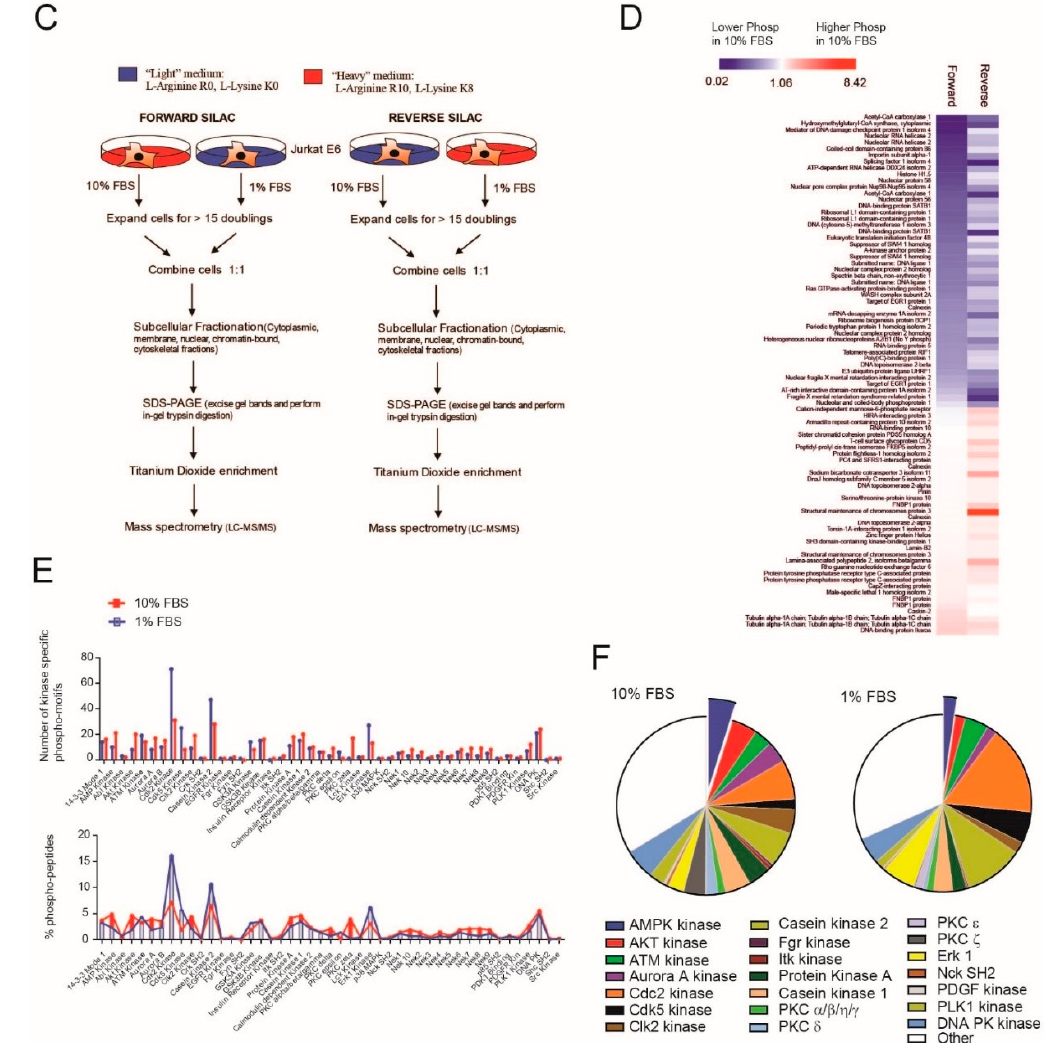
Figure 1. Serum deprivation augments sensitivity to the cytotoxic effects of Hedgehog pathway inhibitors such as GANT-61 through the modulation of numerous signaling pathways. ( A ) Cell viability assays in T-ALL cell lines (Jurkat (24 h), KOPTK1 (48 h), RPMI8402 (48 h), and TALL1 (48 h)) subjected to different culture conditions (10% FBS or 1% FBS) and treated with increasing doses of GANT-61 (5–20 µM). Data are expressed as percentage compared to vehicle (DMSO)-treated control cells (100%). Results of one of three experiments (with similar results) executed in triplicate are shown. Results are shown as the mean ± SD. ** p < 0.01, *** p < 0.001. ( B ) Apoptosis quantification in patient-derived xenografts (PDX; #22, #31, #36) subjected for 48 h to different culture conditions (10% FBS or 1% FBS) and treated with increasing doses of GANT-61 (10–20 μ M). Results of one of two experiments (with similar results) performed in triplicate are shown. Results are shown as the mean ±SD. *** p < 0.001. ( C ) Schematic representation of the experimental setup for SILAC experiments. ( D ) Heatmap representation of differentially enriched phosphopeptides (corresponding to specific proteins) following forward and reverse SILAC experiments. ( E ) Graphical representation of kinase specific phospho-motifs (top) or % phosphopeptides (bottom) for a specific kinase present under nutrient-rich (10% FBS) or depleted (1% FBS) conditions. ( F ) Pie charts representing the main kinases active under each experimental condition based on kinase-specific phospho-motifs present on identified phosphopeptides.